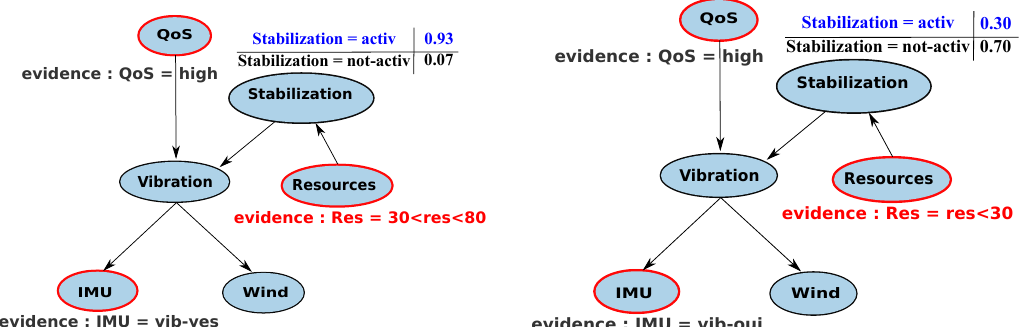
Figure 6. Choice of the solution (error mitigation) adapted to the resources availability using BN.